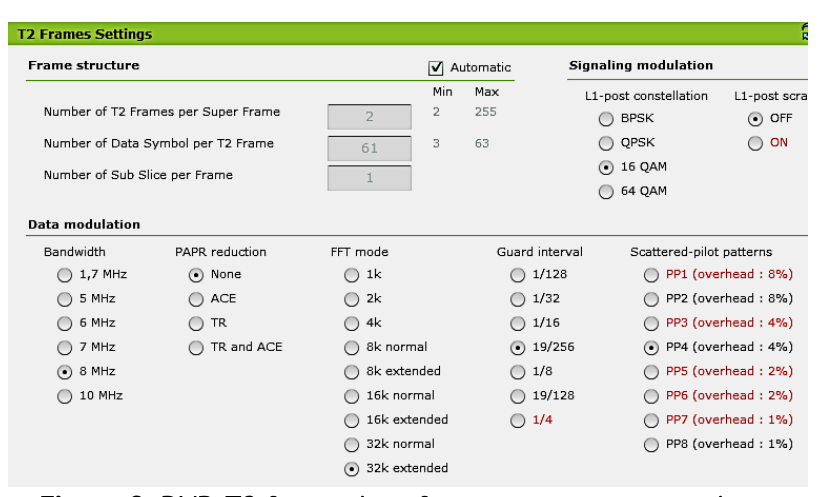
Figure 8. DVB-T2 frame time-frequency resource settings.